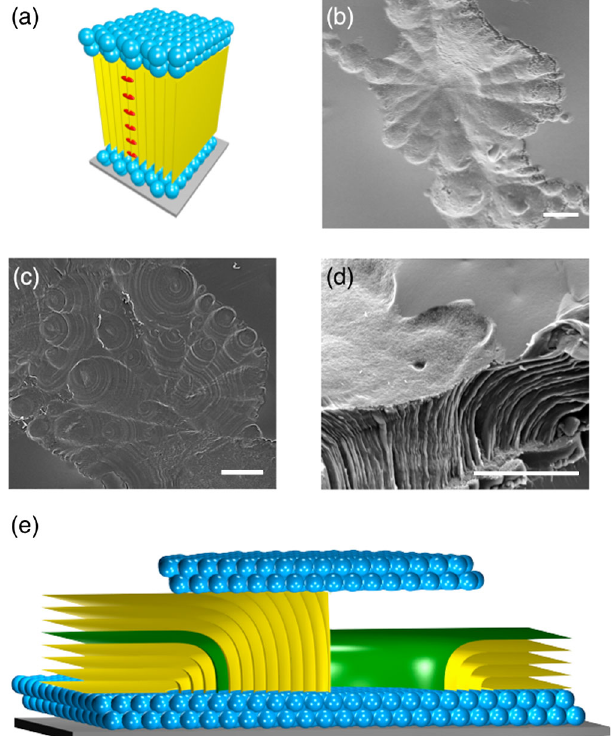
FIG. 2. System B. (a) Schematic illustration of the smectic phase (yellow layers, with representative rodlike molecules in red) between two interfaces covered with silica nanoparticles, shown in blue. (b) Smectic flower texture in a nanoparticle- covered region surrounded by a nanoparticle-depleted region. (c) A less equilibrated smectic flower texture. The smectic layer arrangement at the top interface is visible in the arrangement of the nanoparticles. (d) Cross section of smectic liquid crystal at the boundary between a nanoparticle-covered region and a nanoparticle-depleted region. (e) Schematic illustration of the geometry of (d), with an arbitrarily chosen bent layer colored green to represent the analog of system A’s curved homeotropic interface. All scale bars are 10 (cid:1) m